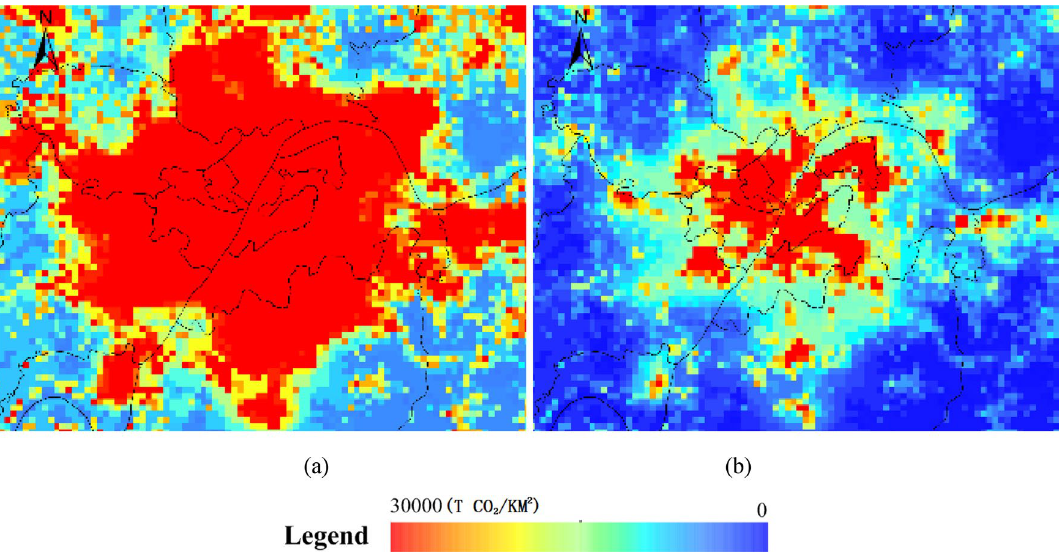
Figure 7. ACDE maps of major metropolitan areas in 2010, ( a ) Model 1, ( b ) Model 2. The figs were generated using the ArcGIS Desktop (ESRI, Inc, Version 10.2, https:// deskt op. arcgis. com/ zh-